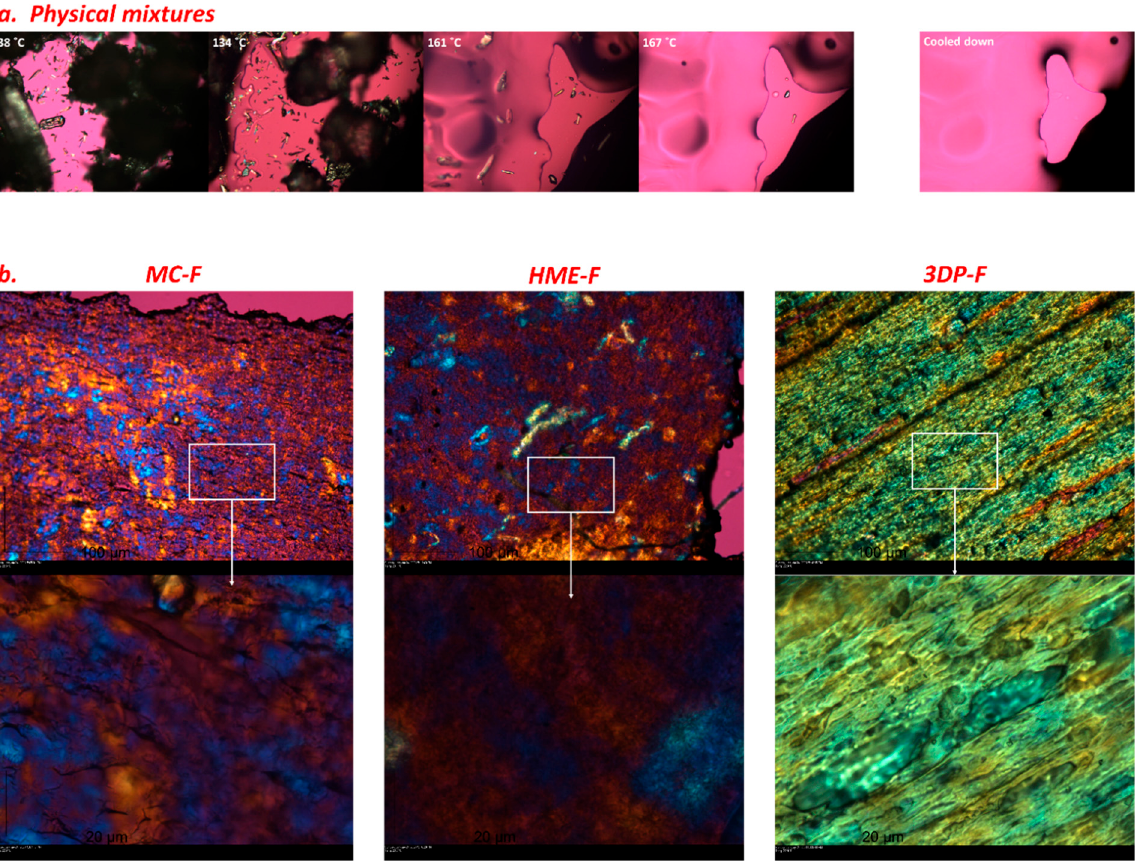
Figure 6. ( a ) The observation of physical mixtures ramped from room temperature to 180 °C, then cooled down to room temperature; and ( b ) morphology of different kinds of films under room temperature.